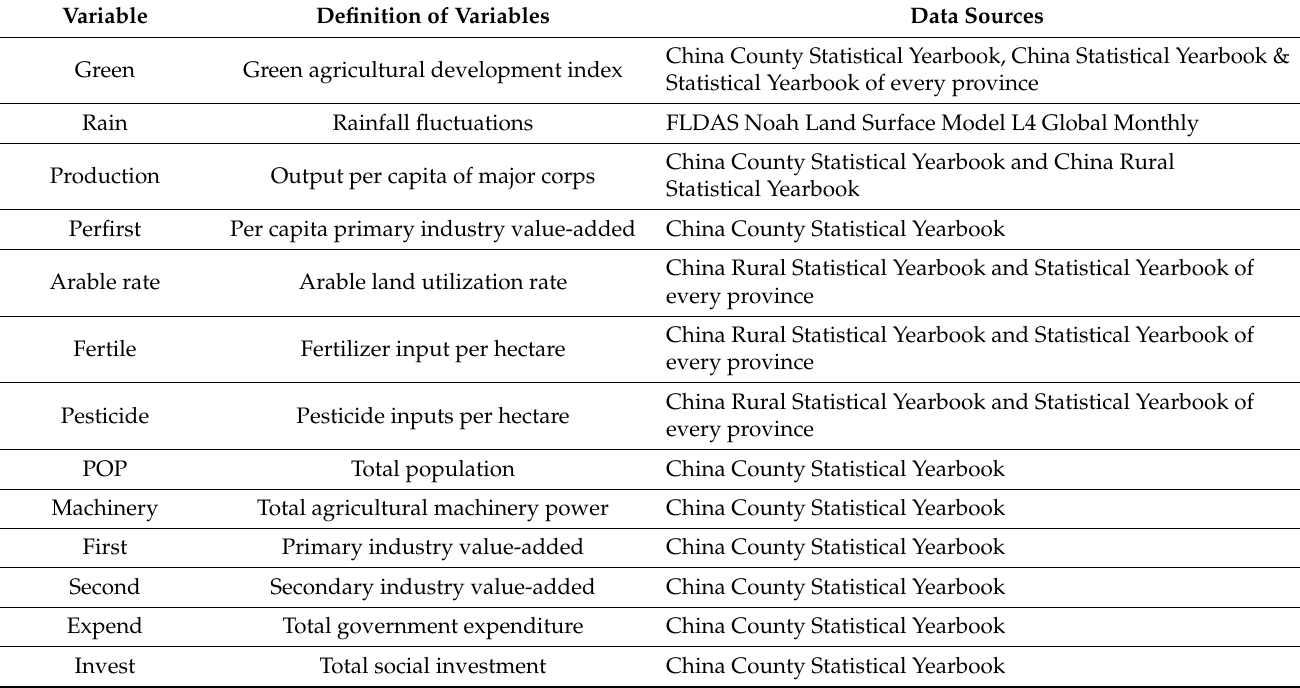
Table 2. Main variable definitions and data